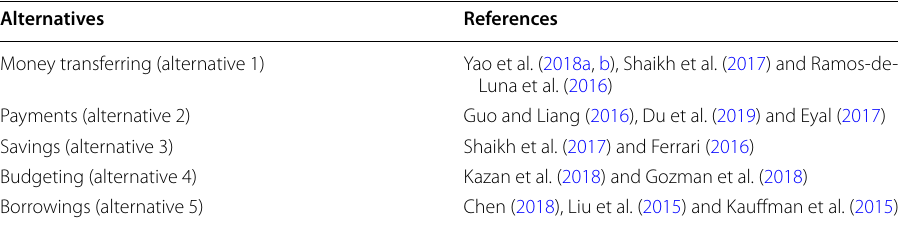
Table 2 Fintech-based investment alternatives for the European banking services. Source : Created by the authors